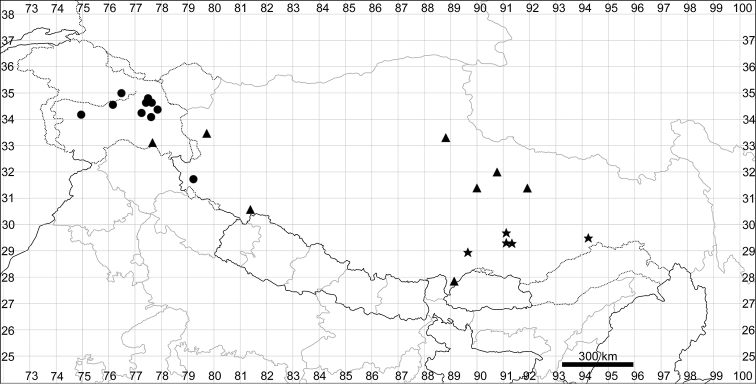
Distribution map of Salsolatragus (circles), S.austrotibetica (stars) and S.monoptera (triangles).